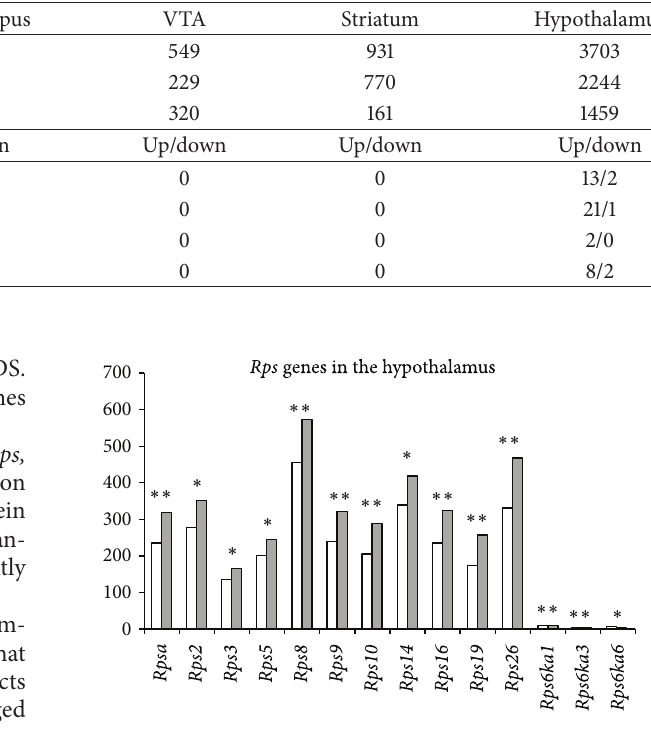
Figure 1: The differentially expressed ribosomal Rps genes in the hypothalamus of mice following CSDS. The Cufflinks program was usedtoestimatethegeneexpressionlevelsinFPKM.Thelevelsofthe Rps gene expression are presented in the control (left columns) and depressive mice (right columns). The Rps14, Rps8, Rps6ka1, Rps9, Rps5, Rps19, Rps16, Rps3, Rpsa, Rps2, Rps26, and Rps10 genes were upregulated, whereas Rps6ka3 and Rps6ka6 were downregulated under CSDS in depressive mice. Statistical significance 𝑃 < 0.01 and 𝑞 < 0.05 . ∗ 𝑃 < 0.01 ; ∗∗ 𝑃 < 0.001 .